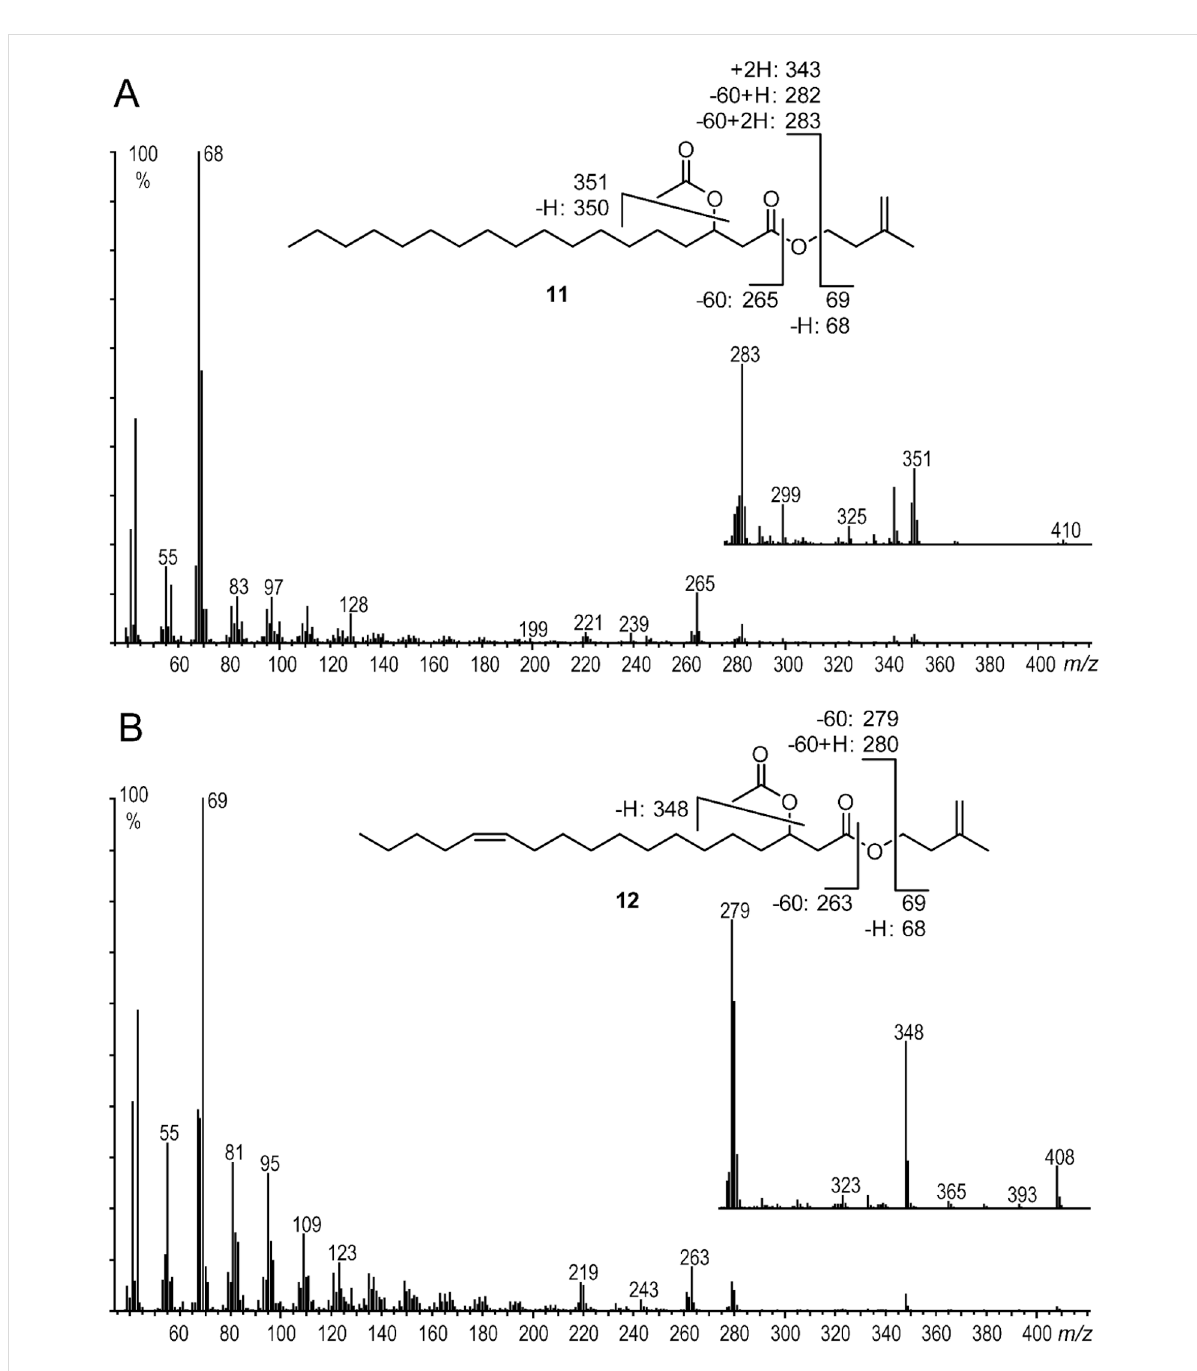
Figure 5: Mass spectra and fragmentation of A: isoprenyl 3-acetoxyoctadecanoate ( 11 ); B: isoprenyl ( Z )-3-acetoxy-13-octadecenoate ( 12 ).